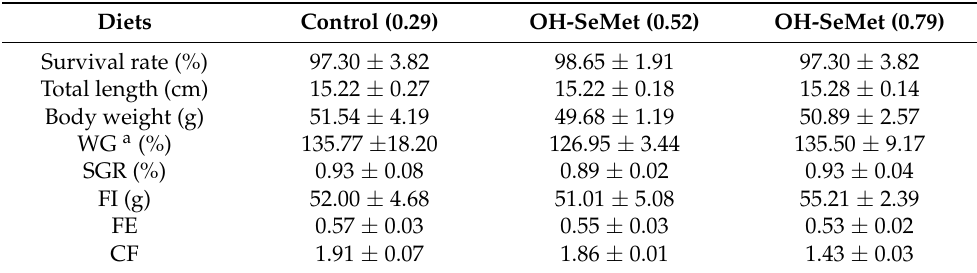
Table 5. Survival, growth performance and feed intake in gilthead seabream after 13 weeks of feeding diets with different supplementation of OH-SeMet.